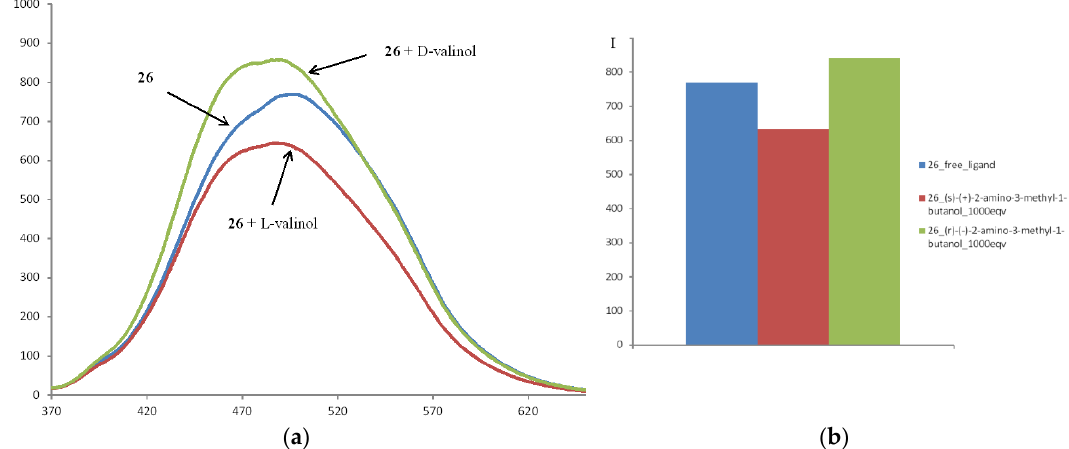
Figure 15. Fluorescence spectra of compound 26 in the presence of L- and D-valinol (1000 equiv.); ( a ) general view; ( b ) schematic representation of the changes in emission.